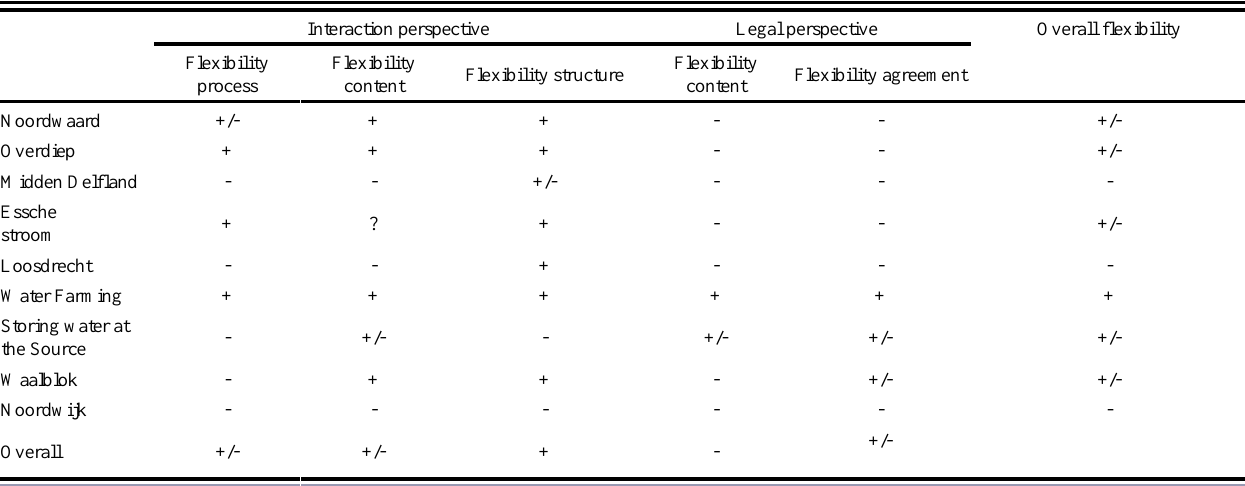
Table 10. Summary of findings: assessing the flexibility of arrangements used (from - to